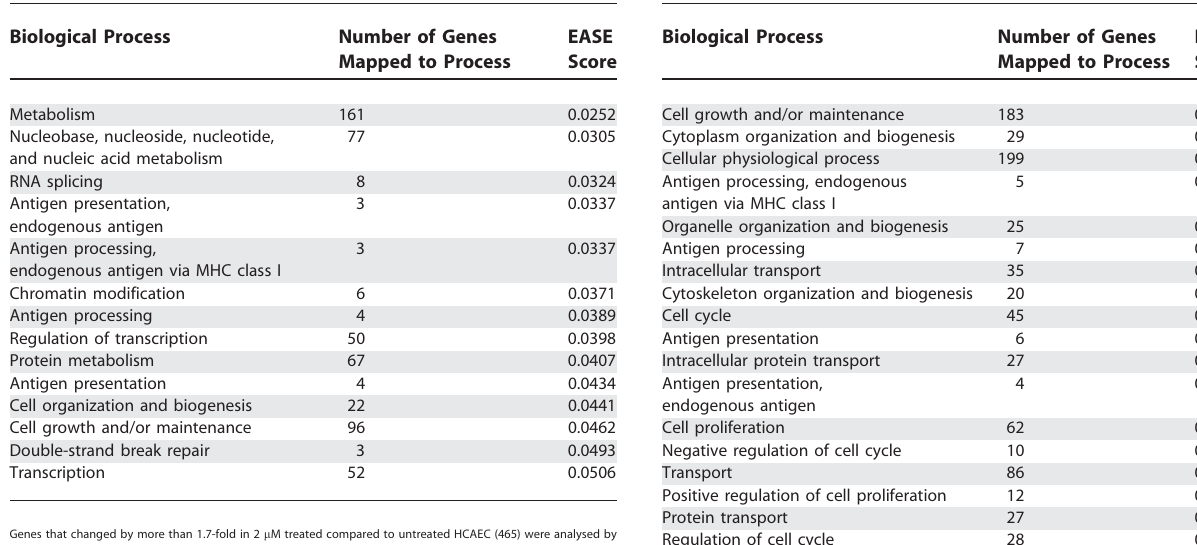
Table 6. Identification of Global Changes in Gene Expression in HCAEC Following Treatment with 100 l M